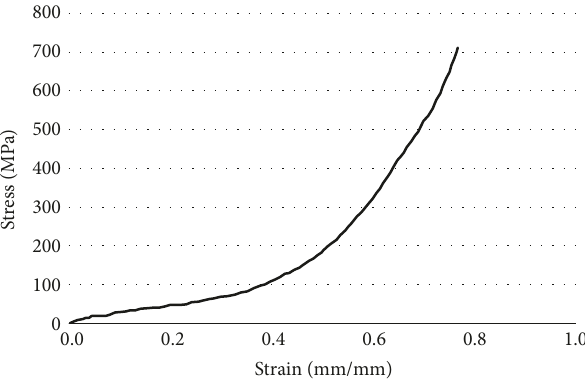
Figure 2: Stress-Strain curve of Ti-Ni under compression. Test was terminated due to load cell